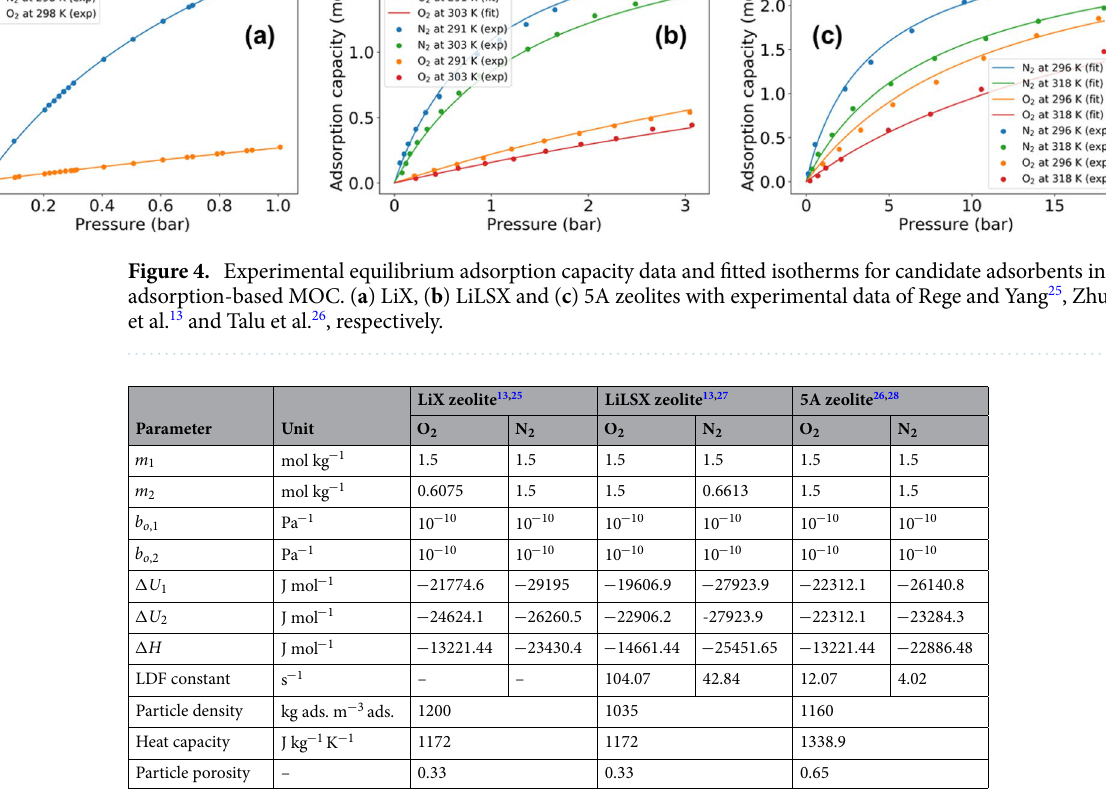
Table 2. Fitted isotherm parameters, heat of adsorption, mass transfer coefficient, and particle characteristics for candidate adsorbent materials.